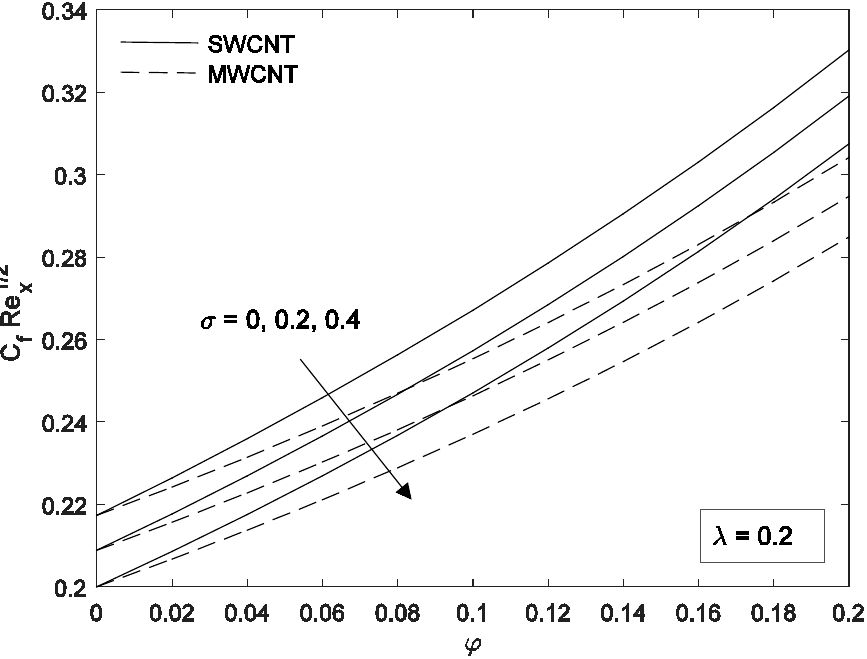
Figure 6. Effect of σ on skin friction for water-based fluid.